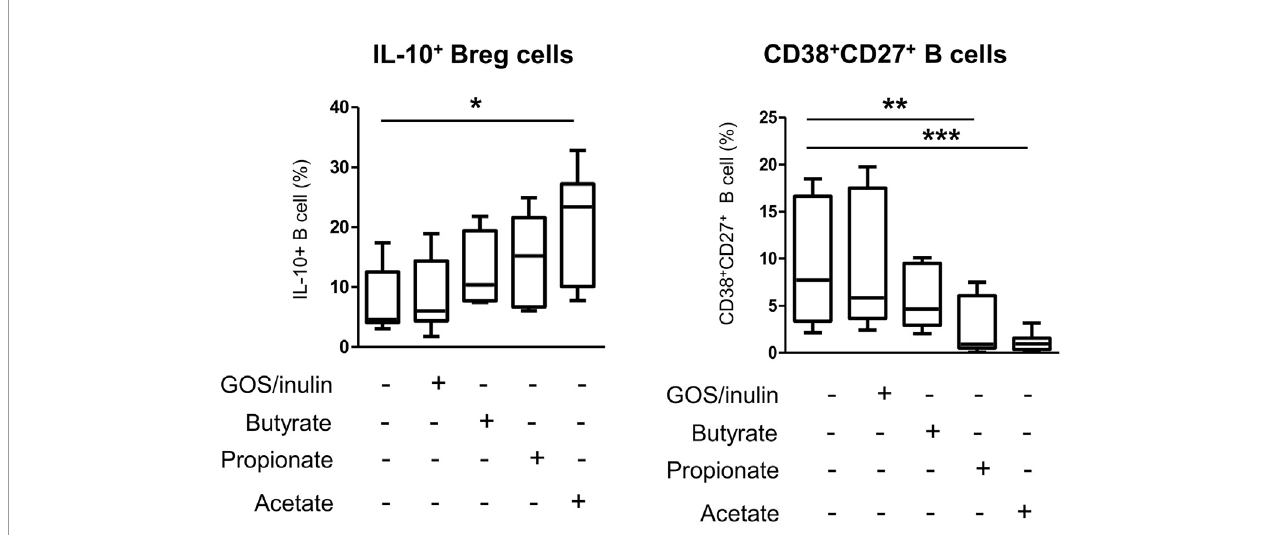
FIGURE 9 | Effects of SCFA (butyrate, propionate and acetate) and GOS/inulin treatment in vitro on human IL-10 + Breg cell and CD27 + CD38 high plasmablast frequencies. Human B cells isolated from PBMCs were cultured for 3 days with GOS/inulin, butyrate, propionate, acetate or no treatment as a control (n=11). The frequencies of IL-10 + B cells and plasmablast CD27 + CD38 high B cells were estimated by fl ow cytometry (* = p<0.05, ** = p<0.01, *** =